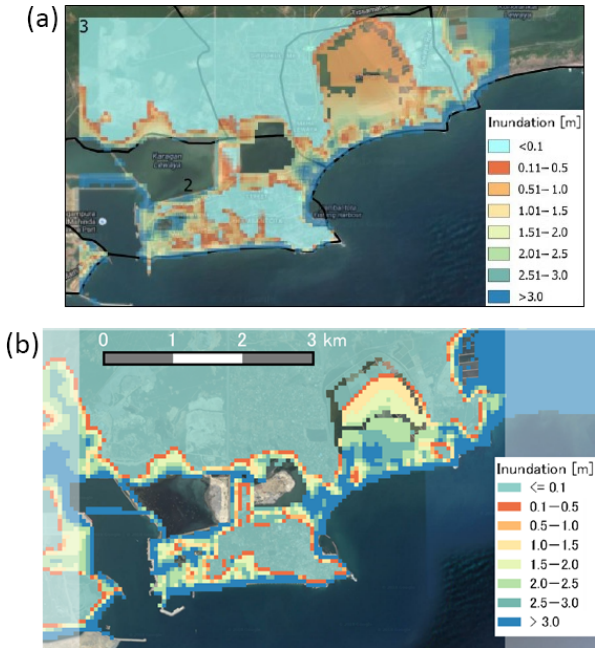
Figure 28. Inundation comparison for Hambantota, Sri Lanka. (a) RIMES model. (b) TRITON-G